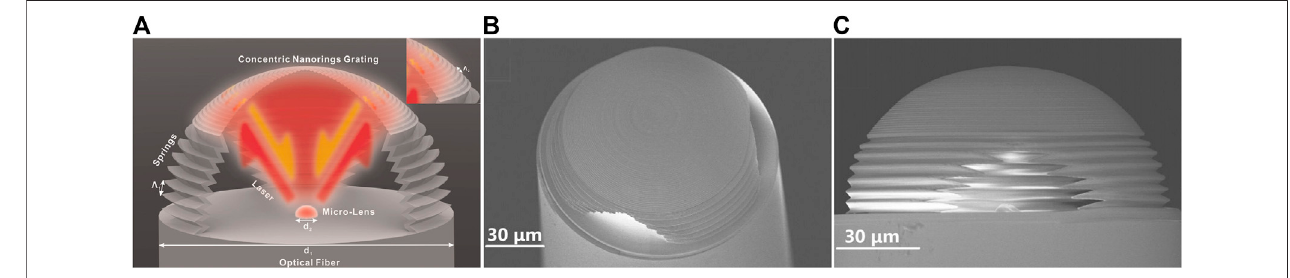
FIGURE 8 | Optical fi ber integrated microphone printed by TPP (Wang et al., 2015). (A) Schematic illustration of the 3D design. (B) Top view of the fi ber microphone. (C) Side view of the fi ber